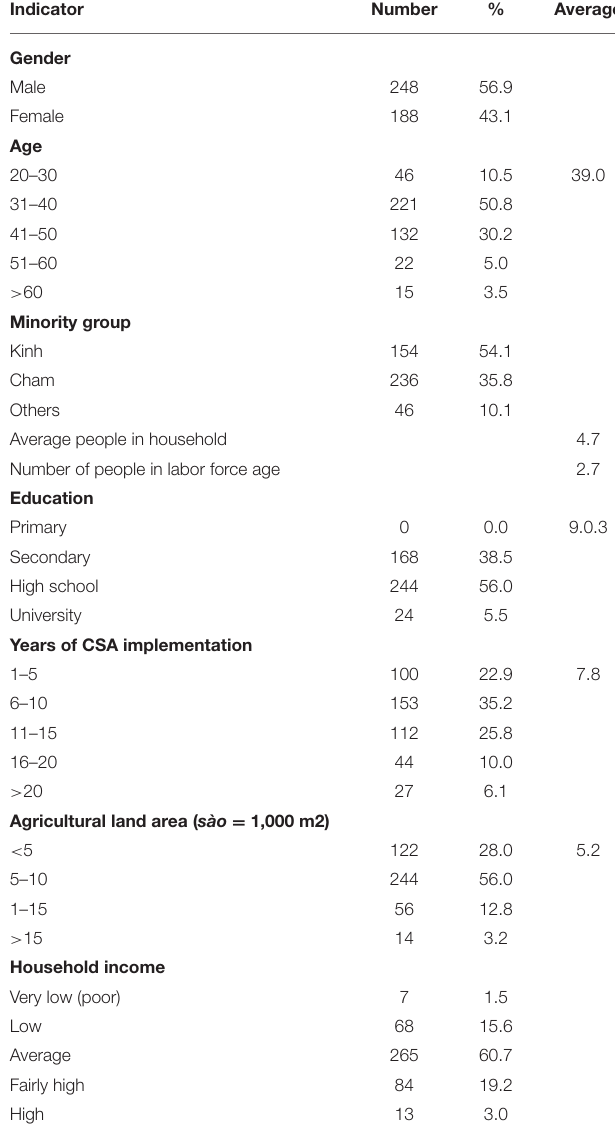
TABLE 3 | Socio-economic characteristics of the